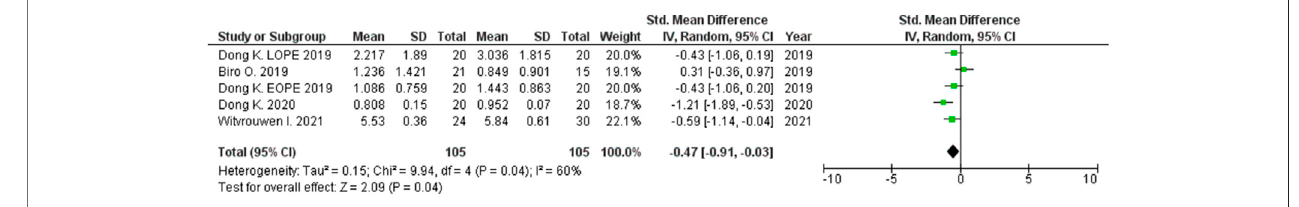
FIGURE 10 | Meta-analysis of differences in expression level of miRNA-16 in peripheral blood between women with vs. without preeclampsia.